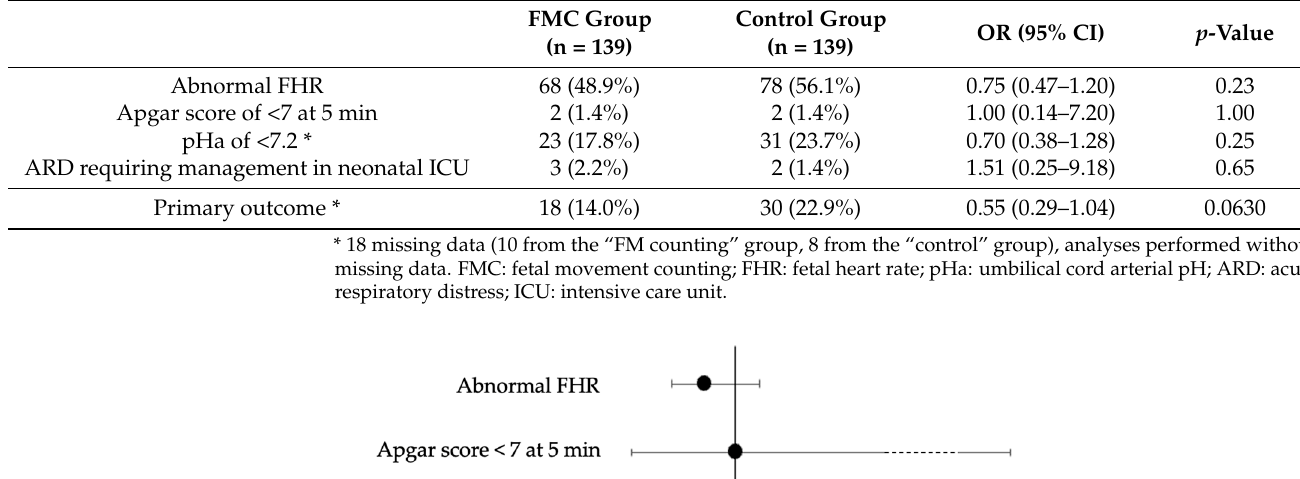
Table 2. Neonatal outcomes. Data are expressed as n (%). Primary outcome is defined as the presence of at least two neonatal morbidity criteria.